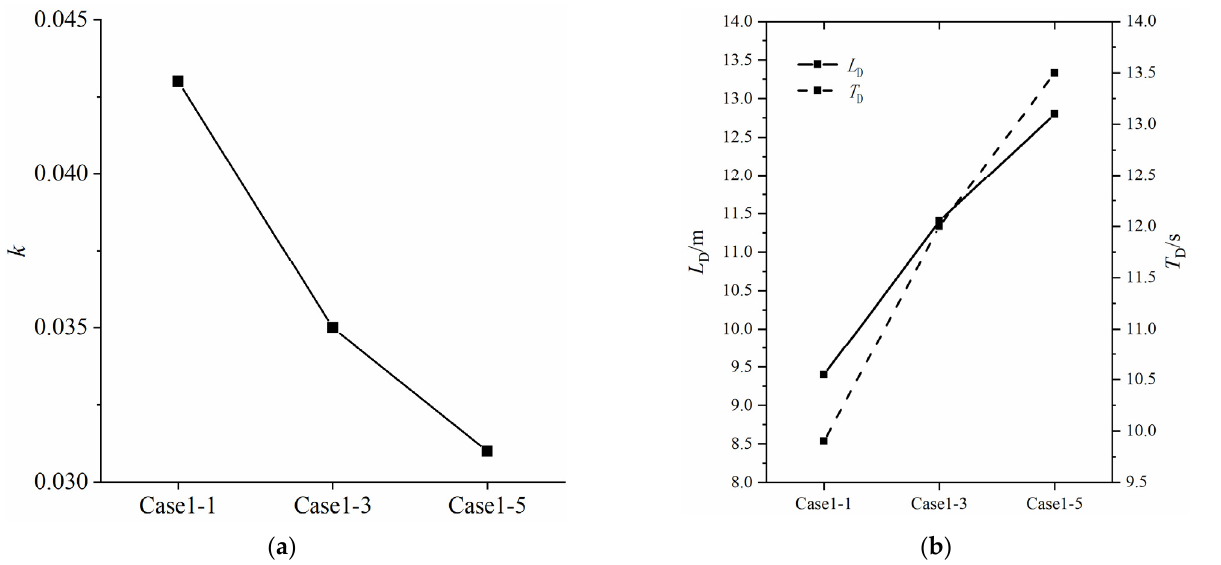
Figure 9. Mass exchange between groin field and main stream: ( a ) dimensionless entrainment coefficient k , ( b ) transient storage capacity indexes L D and T D .